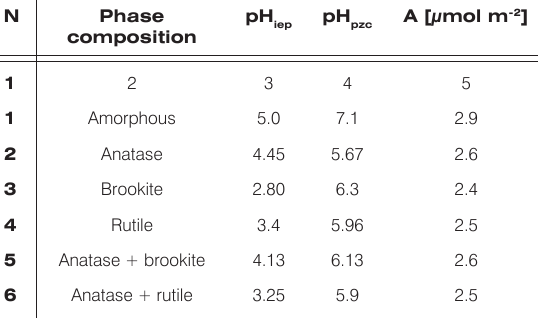
Table 3. Some parameters of titania samples.